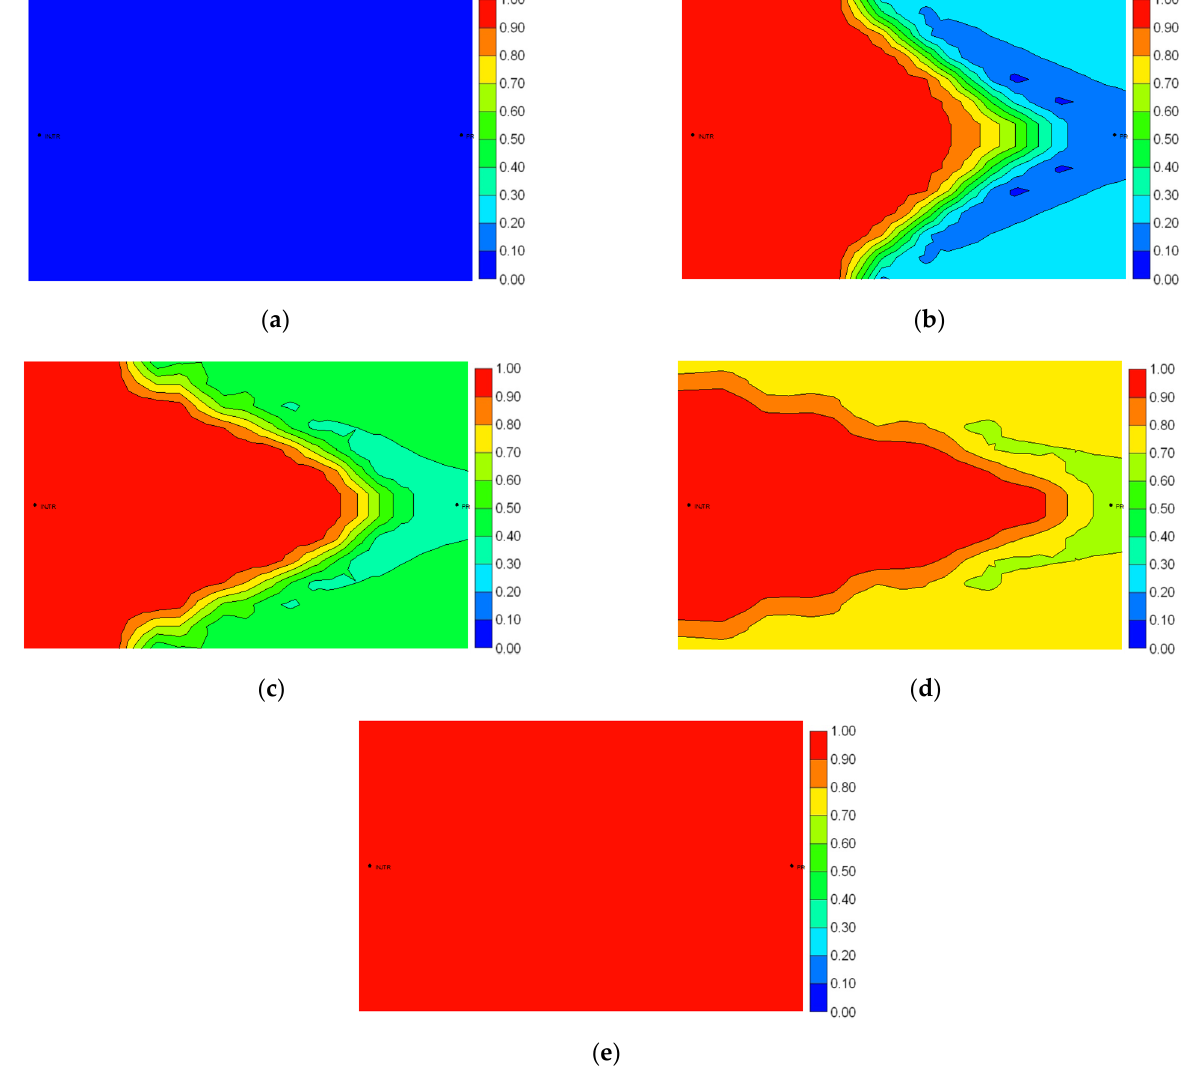
Figure 11. Mass fraction distribution of heavy component after steam flooding. ( a ) mass fraction of heavy components: 0. ( b ) mass fraction of heavy components: 0.25. ( c ) mass fraction of heavy components: 0.5. ( d ) mass fraction of heavy components: 0.75. ( e ) mass fraction of heavy components: